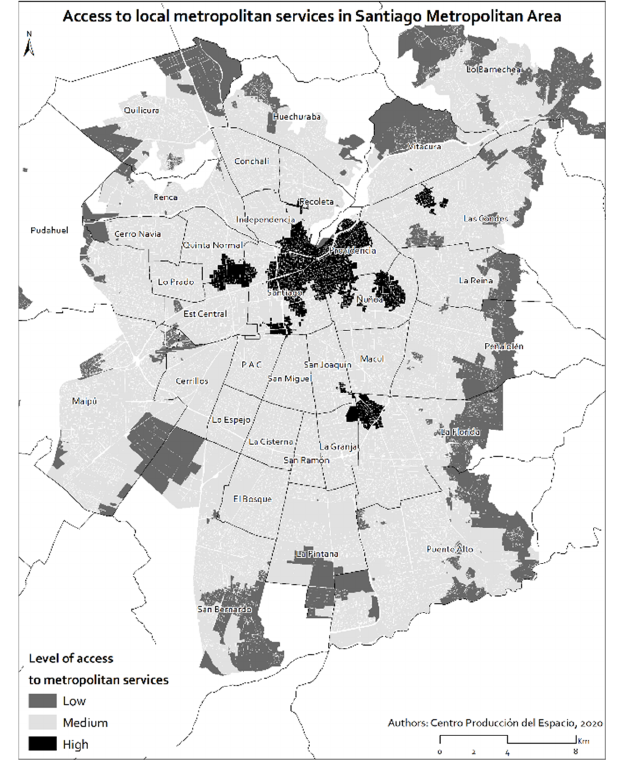
Figure 2. Access to Metropolitan Services in the Santiago Metropolitan Area. Source: